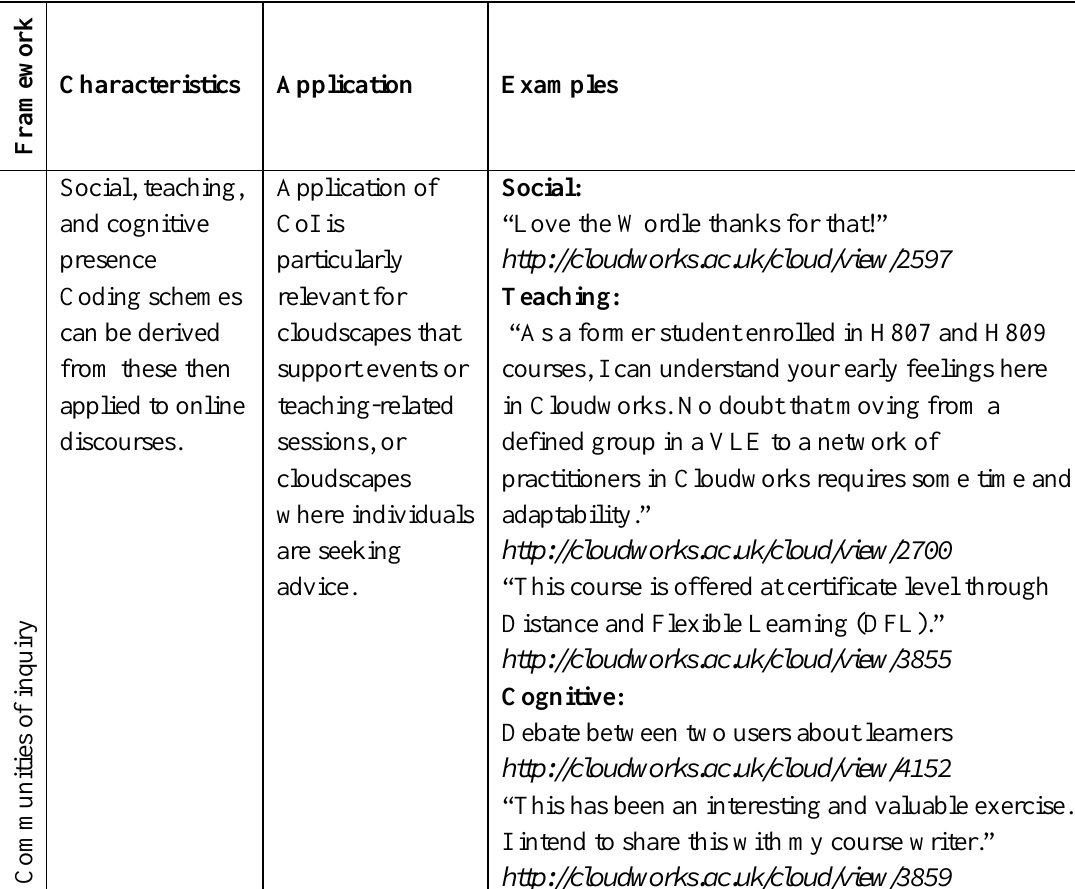
Application of the Four Frameworks to Patterns of User Behaviour in Cloudworks r o w e m a r F